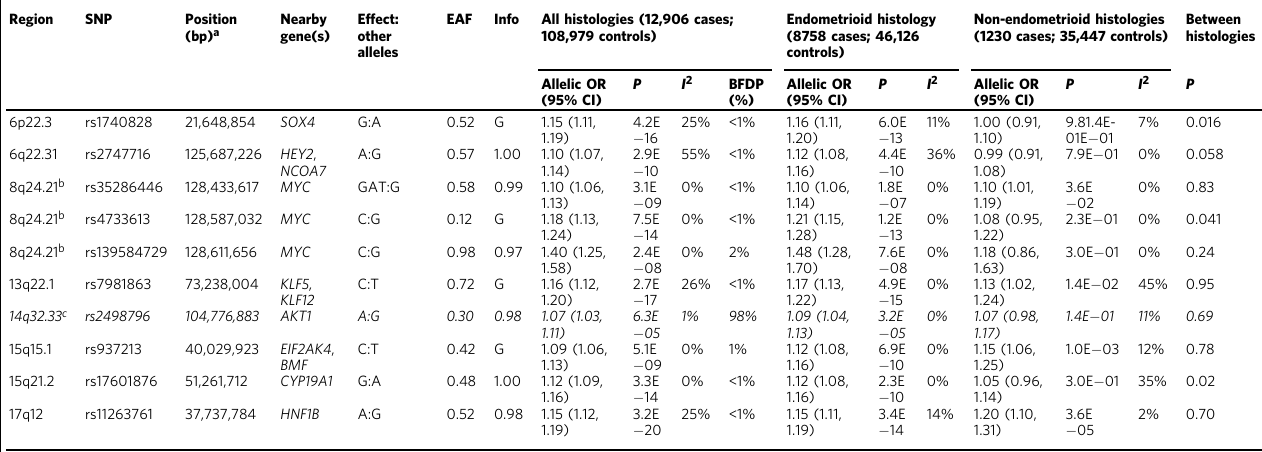
Table 1 Meta-analysis results for previously identi fi ed genome-wide signi fi cant endometrial cancer risk loci Region SNP Position Nearby (bp) a